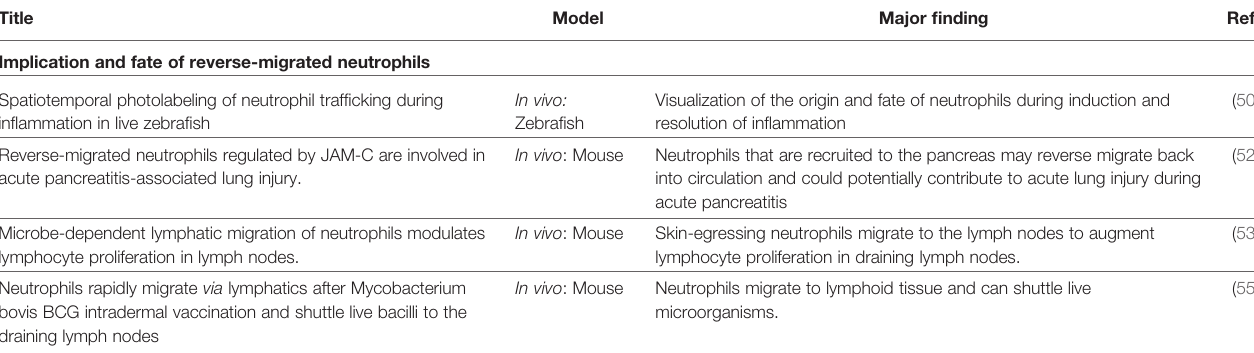
TABLE 3 | Summary of studies on the fate of reverse migrated